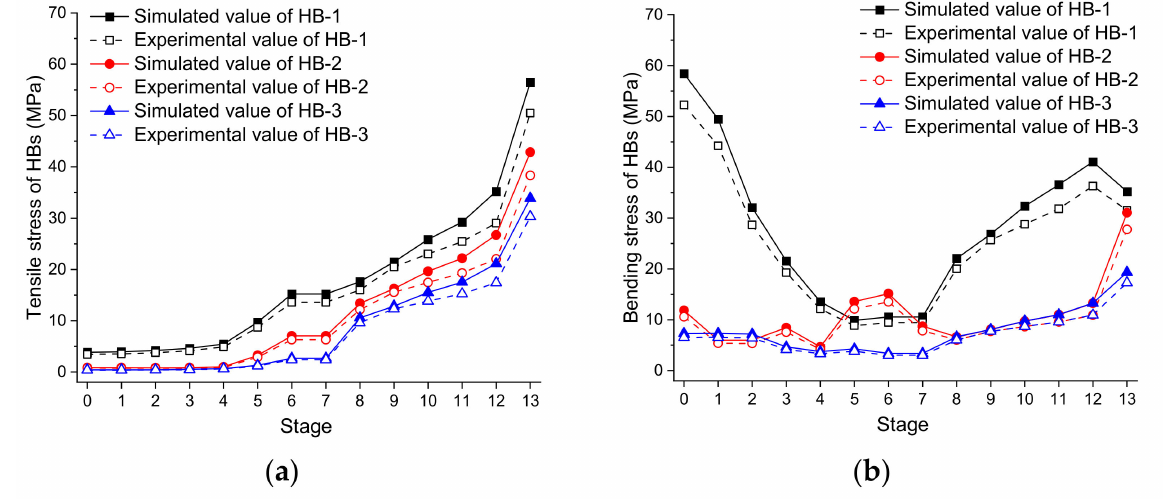
Figure 22. Stresses of HBs. ( a ) Tensile stress; ( b ) Bending stress.